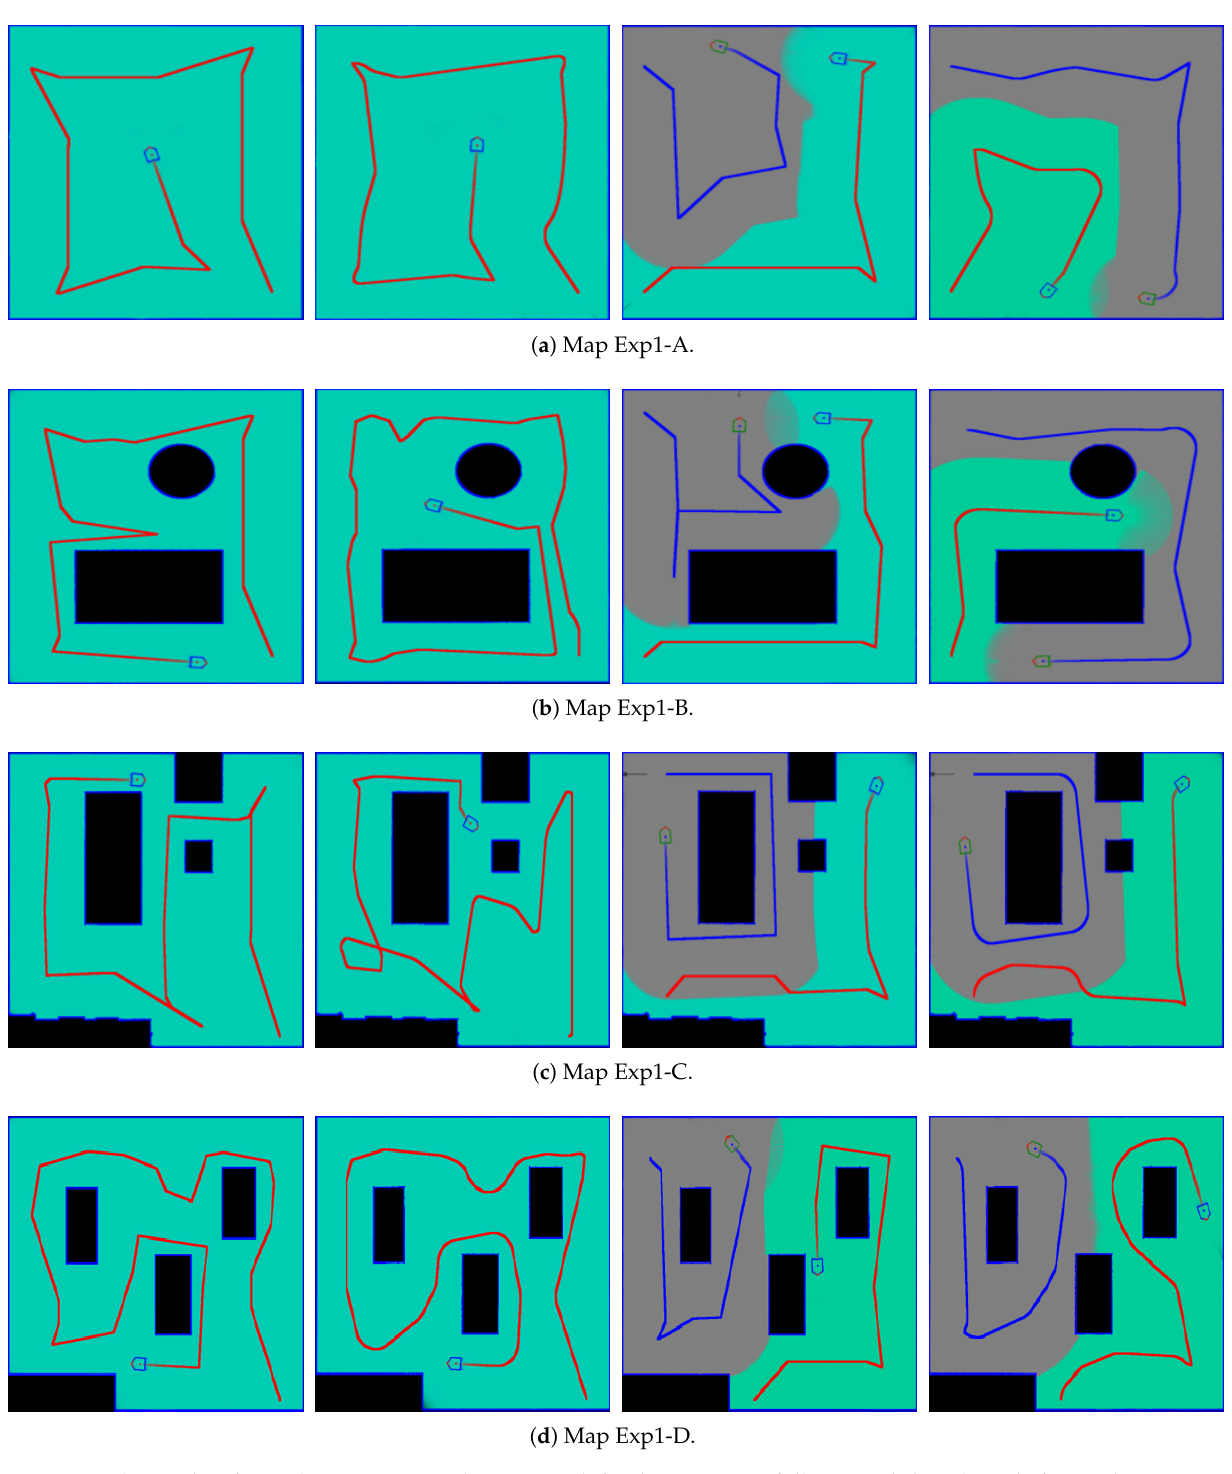
Figure 3. The results of complete coverage and motion path for the two cases: full stop and slow down before making turns. From the left to the right: single robot with full stop, single robot with slow down, multiple robots with full stop, multiple robots with slow down. Observe that the trajectories can be fairly diverse due to the different motion control